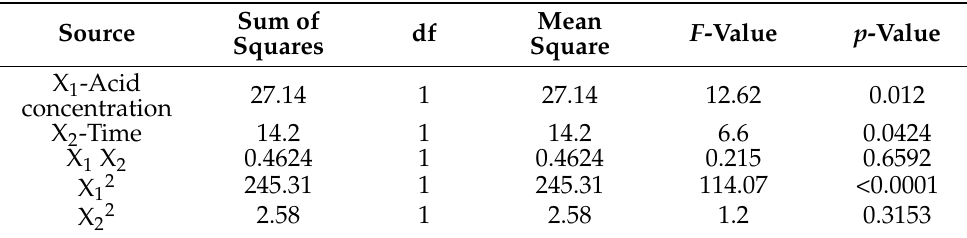
Table 4. Estimation of the regression coefficients and their significance analysis for the CNC quadratic